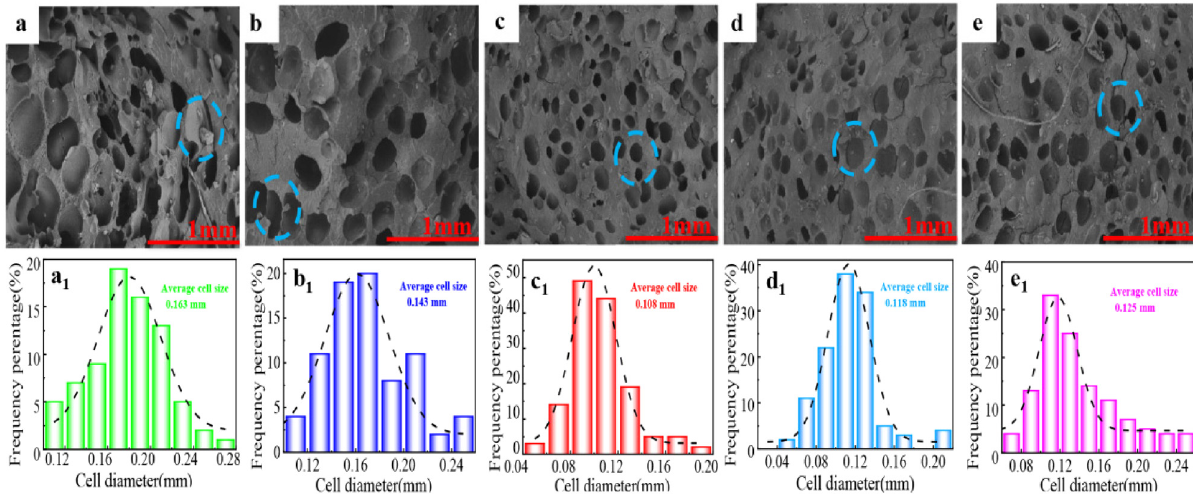
Figure 4: Cell structure ( a – e ) and the cell size distribution ( a 1 – e 1 ) of the PP foaming composites. ( a ) PP@SB, ( b ) PP/EP@SB, ( c ) PP/PA/ EP@SB, ( d ) PP/SA/EP@SB, ( e ) PP/CA/EP@SB.